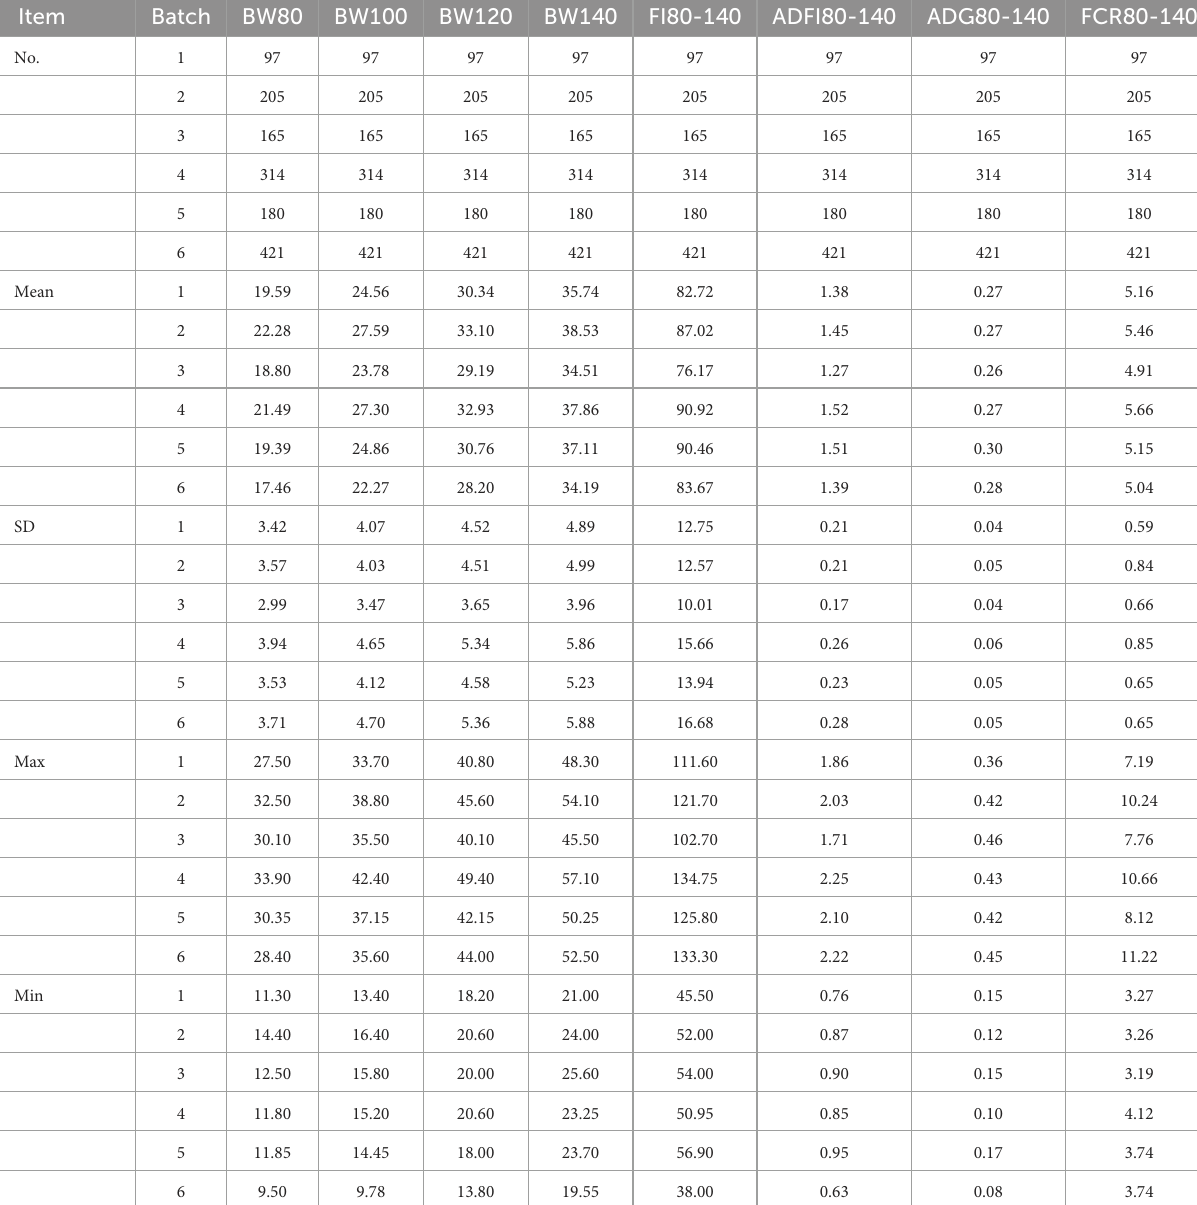
TABLE 1 Descriptive statistics on traits correlated with FCR for SHISA3 and RFC3